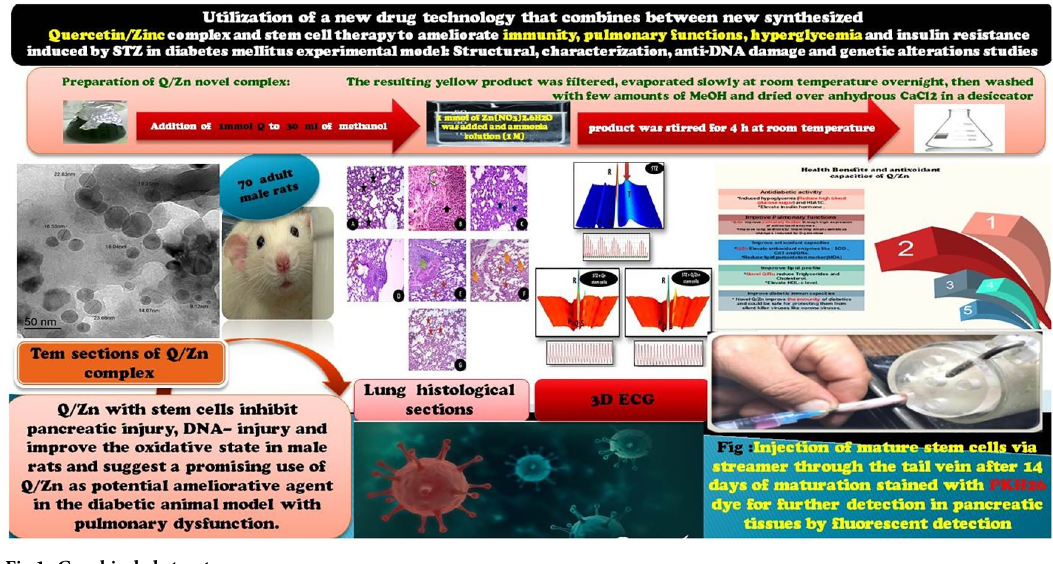
Fig 1. Graphical abstract.